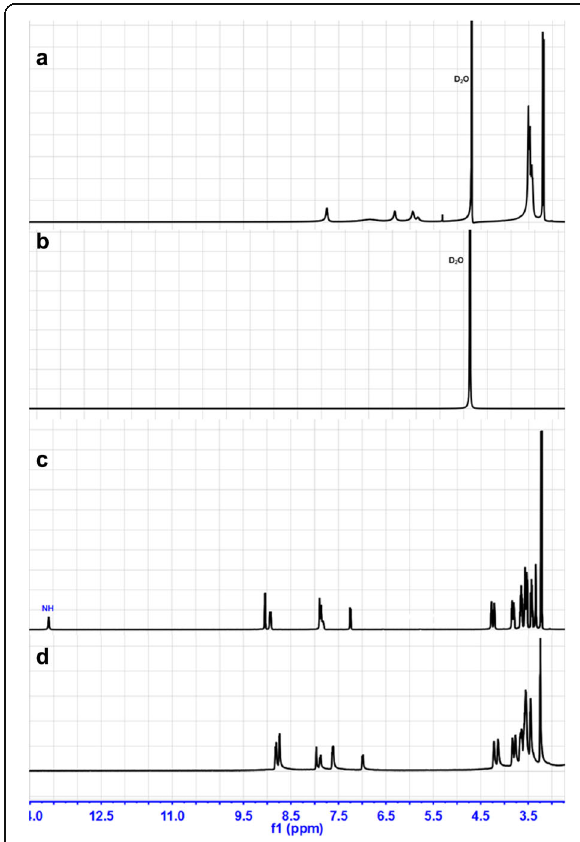
Fig. 5 The 1 H NMR spectrum of BMIP in a D 2 O and c DMSO- d 6 ; the 1 H NMR spectrum of BMIP after the additions of NaOH in b D d DMSO- d